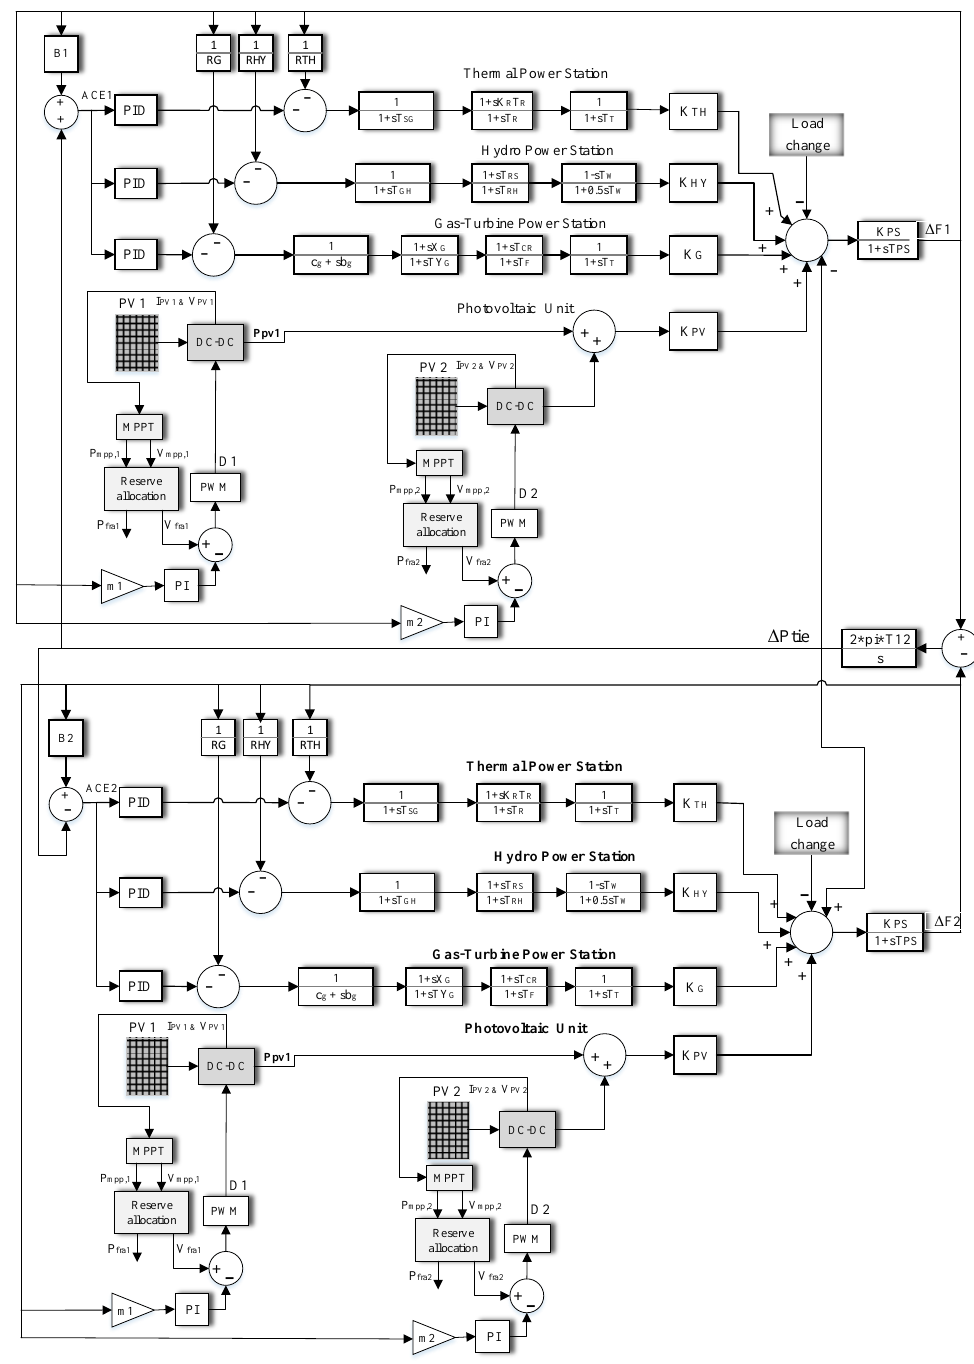
Figure 10. Linear model of the two-area power system.